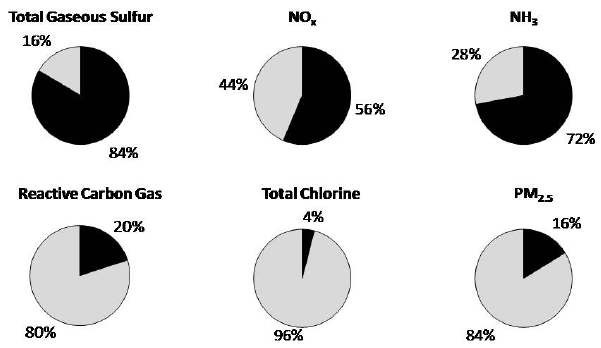
Fig. 10. Relative proportions of anthropogenic (solid black) and natural (gray) emissions within the modeling domain for the modified VISTAS July 2002 emissions inventory developed for this study. “Total Gaseous Sulfur” represents the sum of sulfur in SO 2 +DMS+H 2 S. “Reactive Carbon Gas” represents the sum of carbon in non-methane VOCs+CO. “Total Chlorine” represents the sum of chlorine in HCl+ClNO 2 +sea salt. The PM 2.5 comparison includes sea salt in the fine particle fraction.